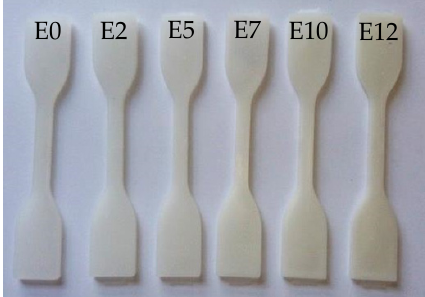
Figure 1. The samples after injecting.